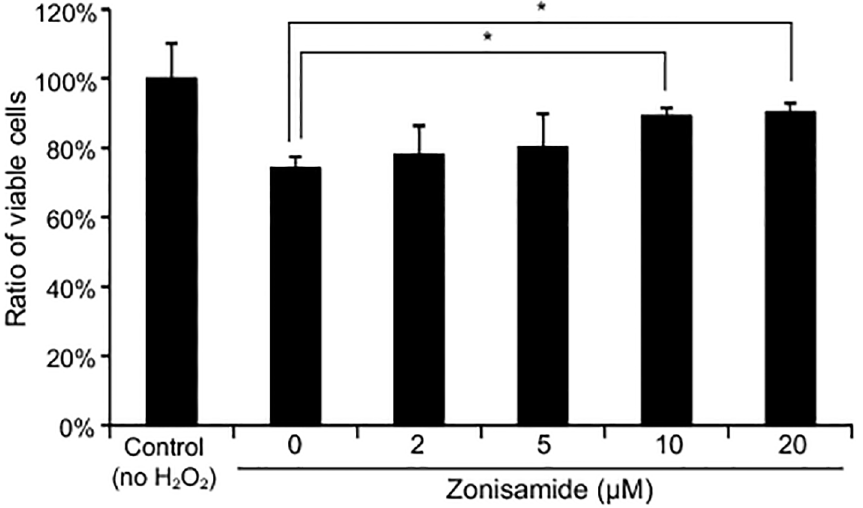
Fig 4. Zonisamide rescues cell death due to oxidative stress. Primary motor neurons in DMEM/F12 with 0.5% FBS were treated with variable concentrations of zonisamide. After 1 h, cells were exposed to 100 μ M hydrogen peroxide (H 2 O 2 ) for 24 h. The number of viable cells was estimated by the MTS assay and was normalized to that without H 2 O 2 (control). Mean and SE are indicated (n = 6). * p < 0.05 by one-way ANOVA followed by Tukey